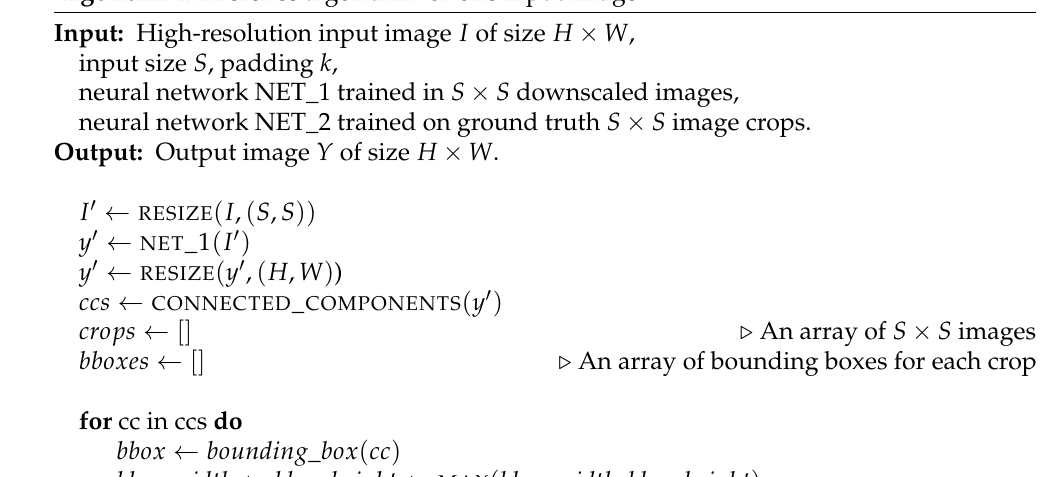
Algorithm 1 Inference algorithm for one input